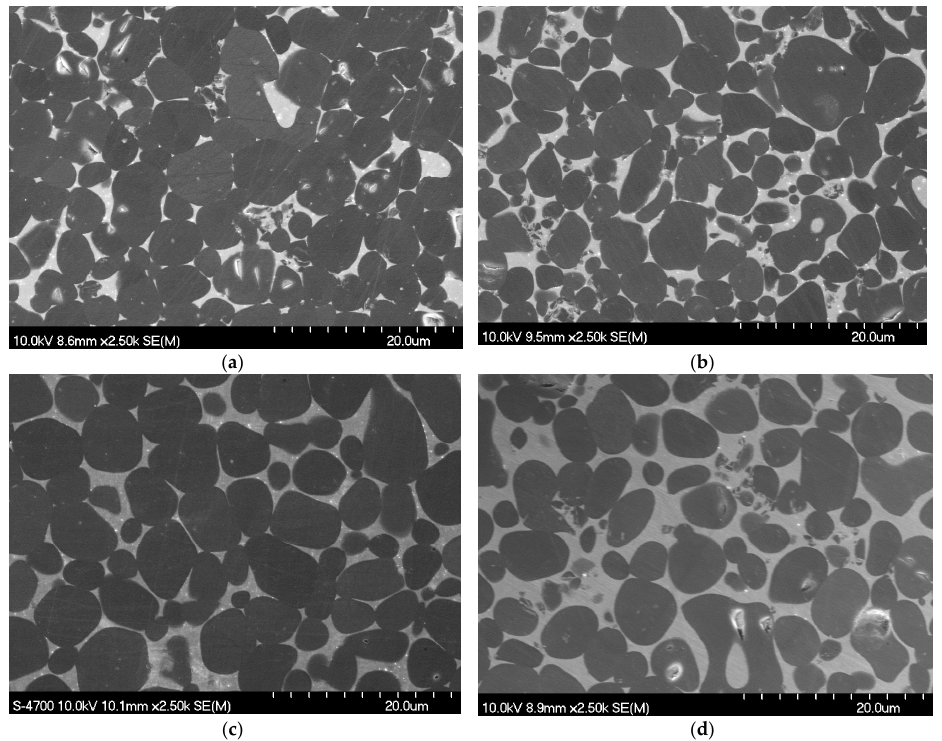
Figure 1. Representative SEM images of TiC–stainless steel cermets prepared with: ( a ) TiC-10 vol. % 304 L; ( b ) TiC-20 vol. % 316 L; ( c ) TiC-20 vol. % 410 L; and ( d ) TiC-30 vol. % 410 L.